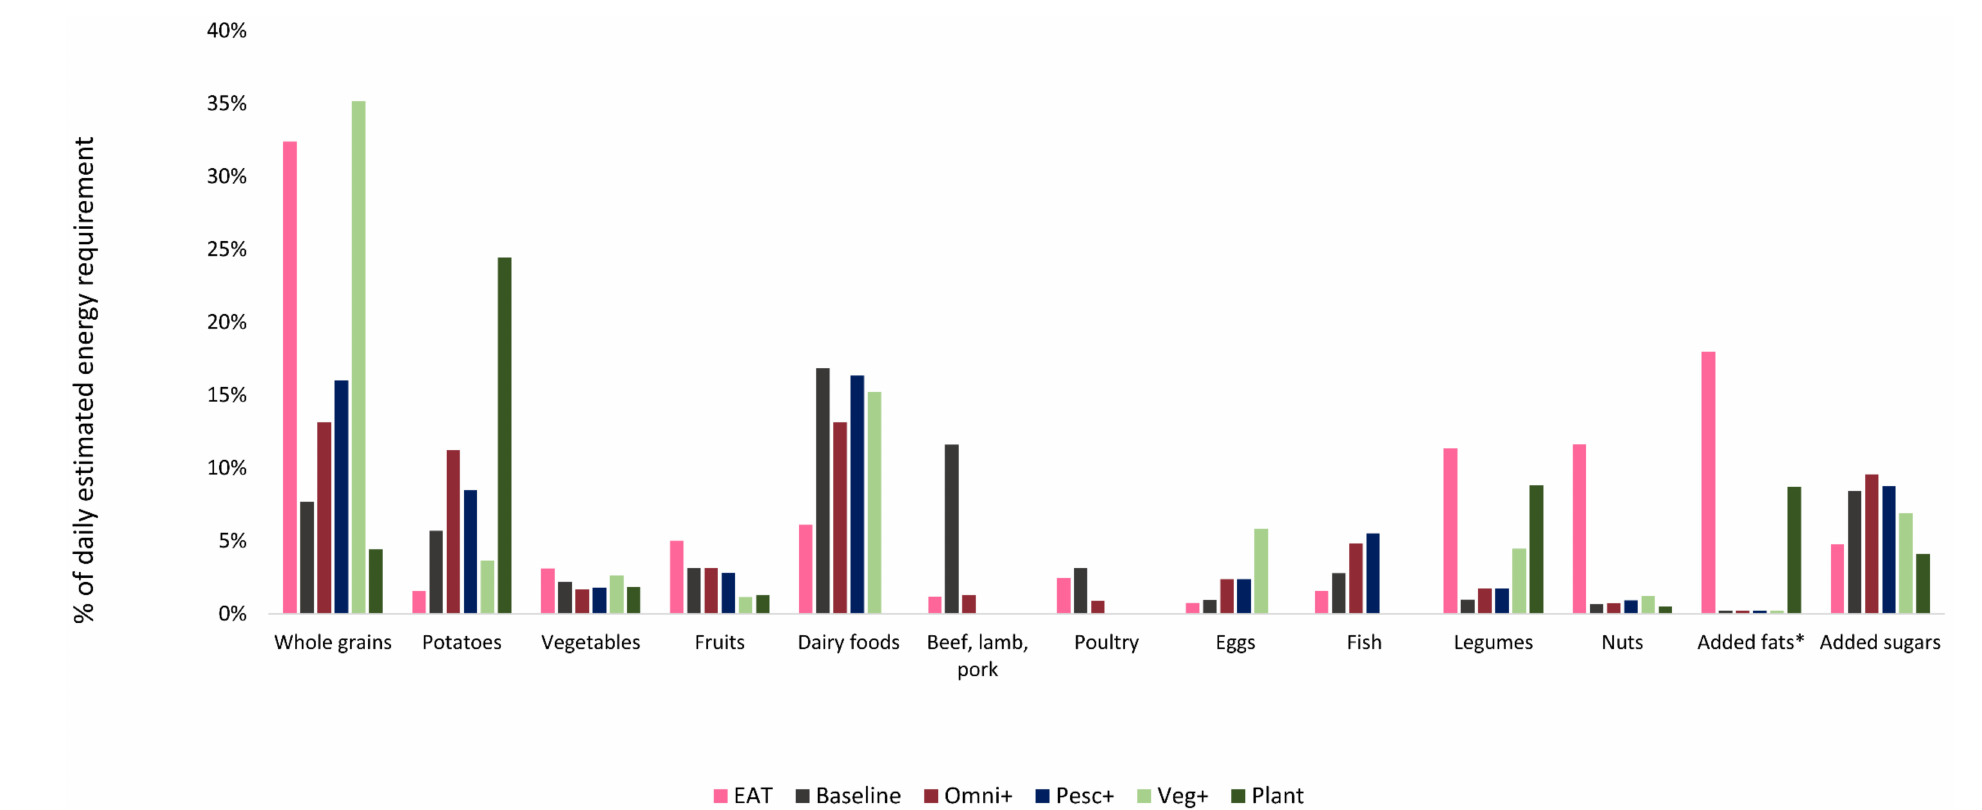
Figure 1. Comparison between the EAT-Lancet diet and (baseline and optimized) diets of Swedish Adolescents. Columns represent the percent of the daily estimated energy requirement for different food groups in the EAT-Lancet diet, the observed (baseline) diet, and in the four main optimized diets (“Omni+”, “Pesc+”, “Veg+”, ”Plant”). Food categories used in this comparison were based on the ones used for the EAT-Lancet diet [5]; * Added fats exclude dairy-based fats (such as butter), which are included in “Dairy